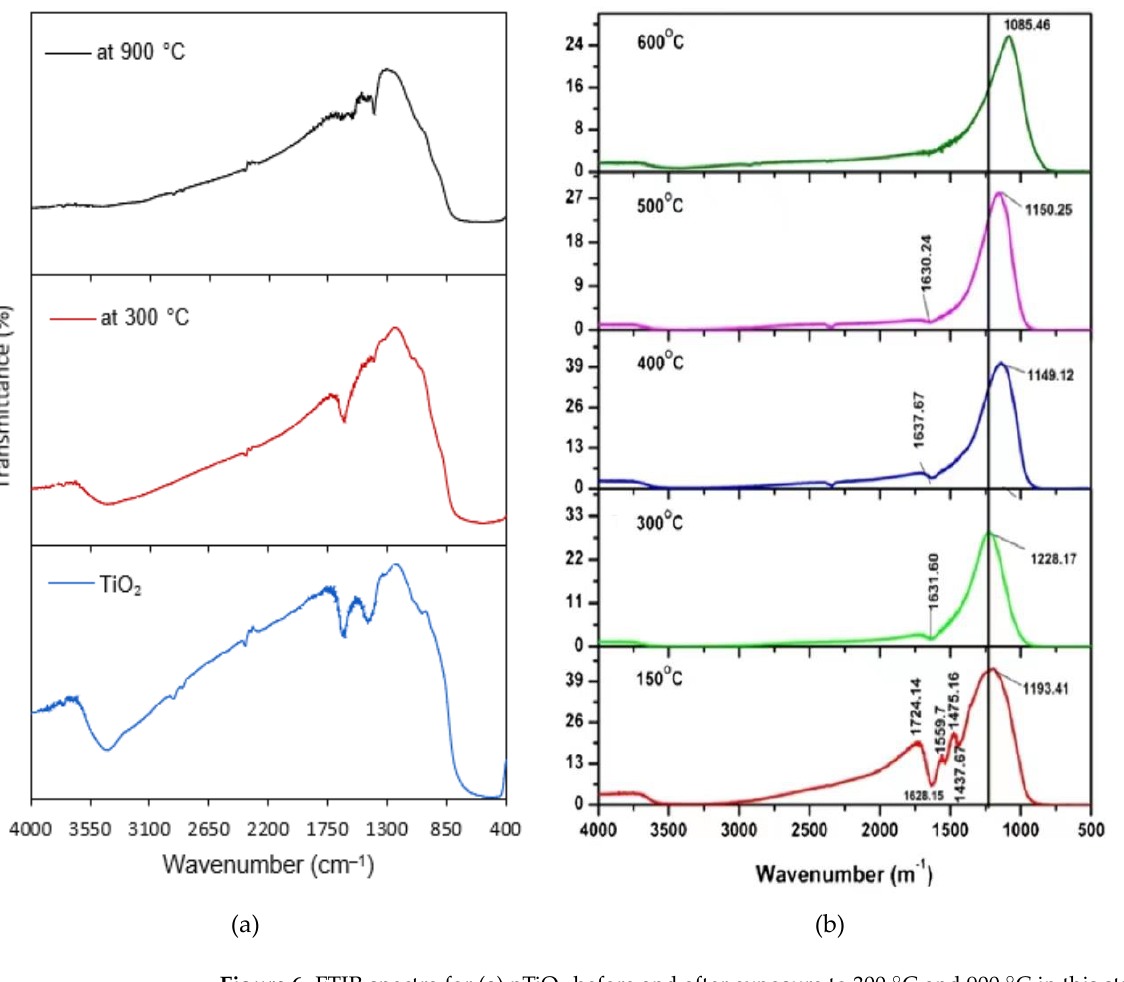
Figure 6. FTIR spectra for ( a ) nTiO 2 before and after exposure to 300 °C and 900 °C in this study and ( b ) TiO 2 transformation with temperature from anatase to rutile. Adapted from Ref.